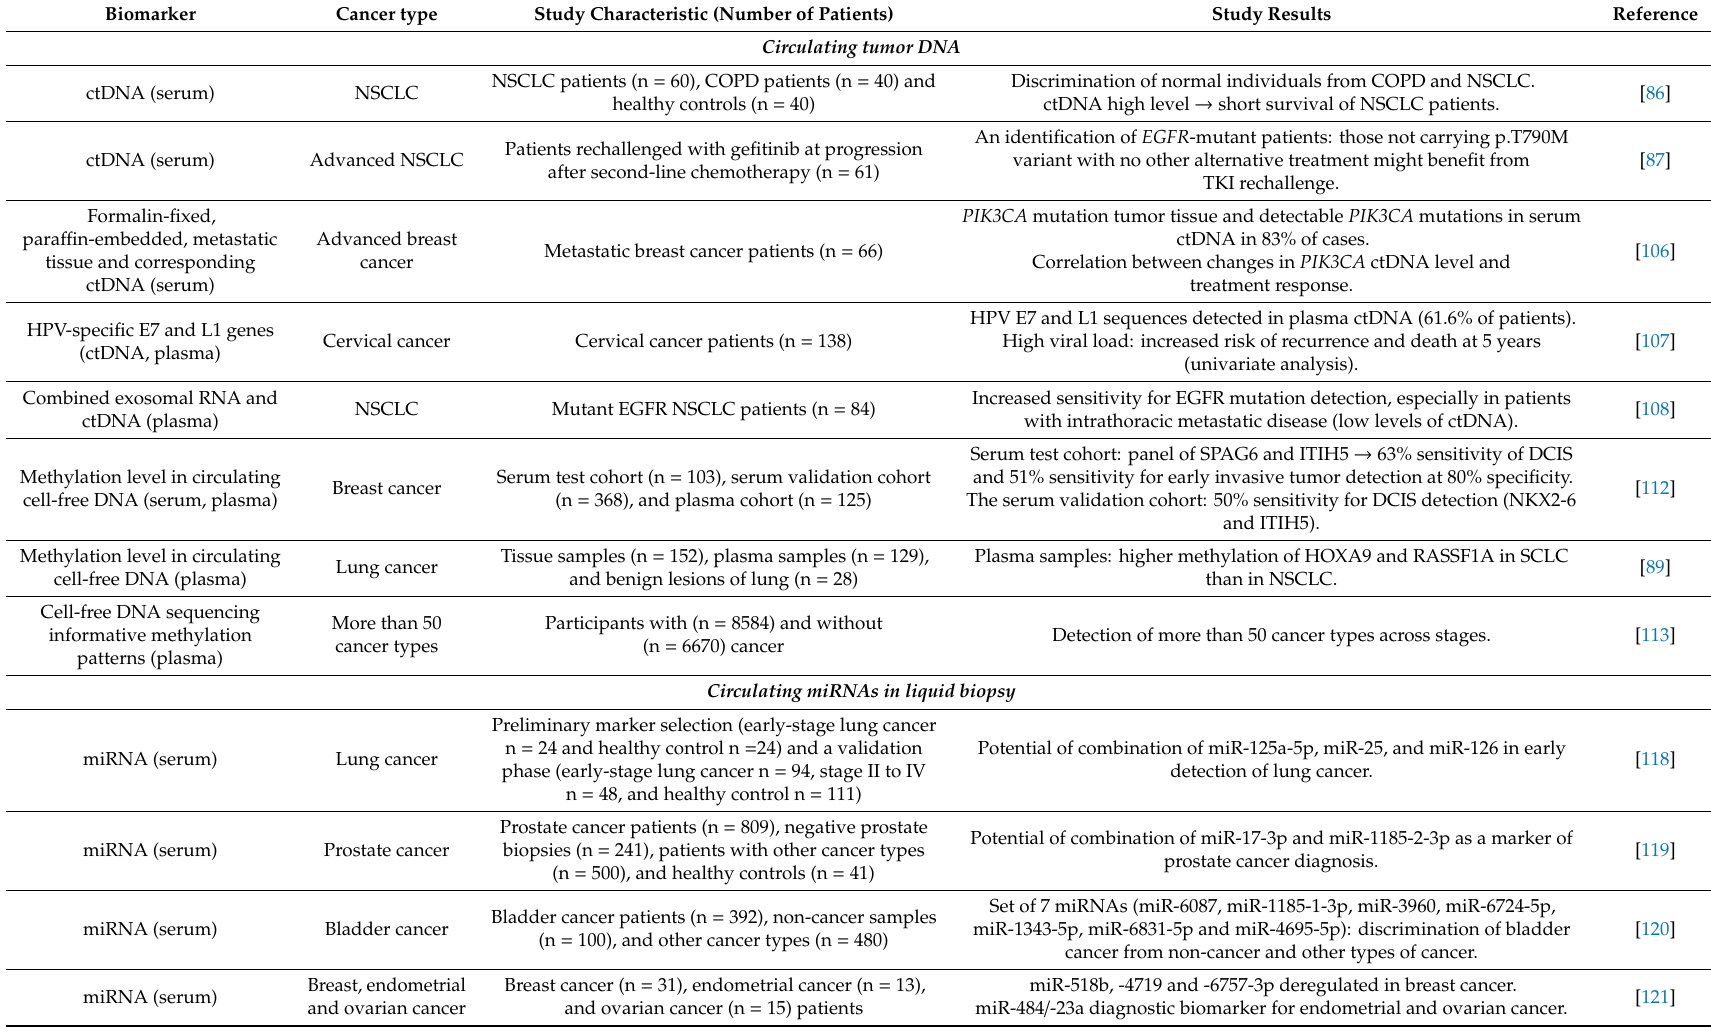
Table 2. Blood-based liquid biopsy: potential roles of biomarkers for cancer